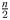
A → B efficiency vs detection.The red line indicates the significant level of connections indicating transfer of information between regions. Here we use tmax = 10, μ = 1, wE = 0.5, wI = −1. The networks are randomly initialized with n ranging from 50 to 1000 with nobs = 50, k1 ∈ {2, 3}, and kA ranging from n2 to 2n with kB = 0.